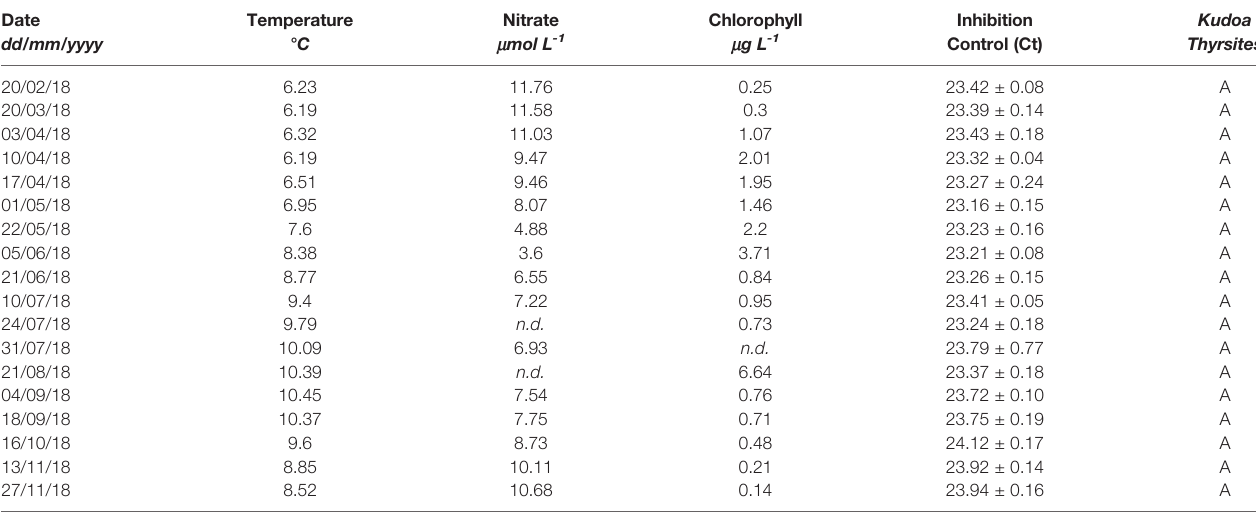
TABLE 3 | Biogeochemical characteristics of Faroese shelf waters during eDNA survey of K. thyrsites